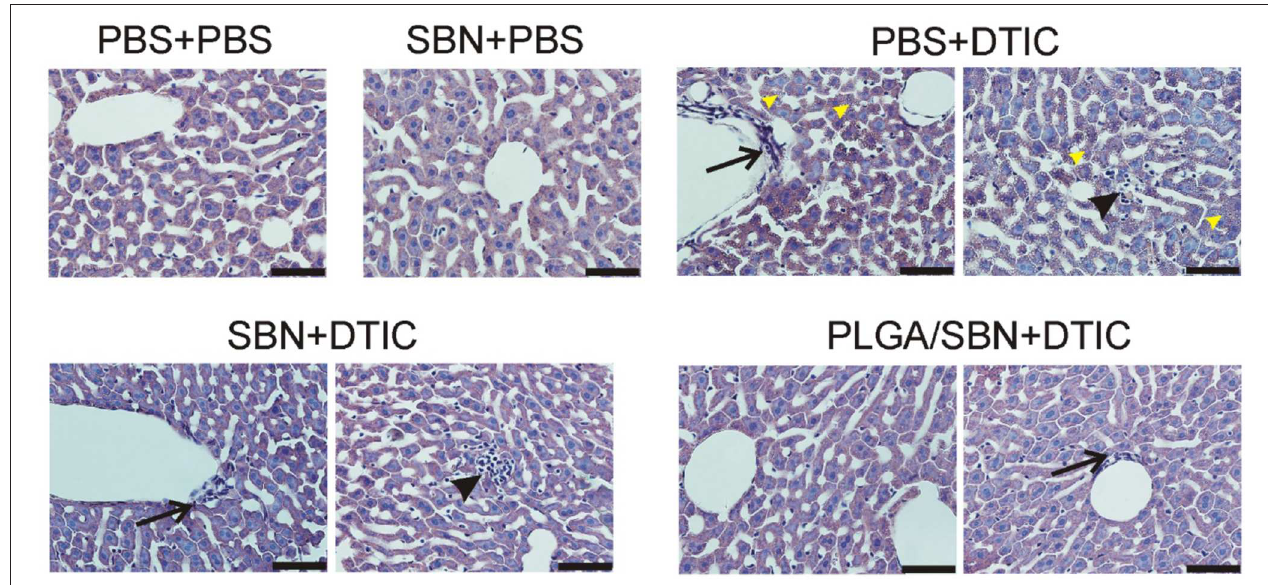
FIGURE 6 | Morphology of liver tissue after chemotherapy with DTIC. Tissue slices of 5 µ m thickness were stained with haematoxilyn-eosin. Black arrows denote mononuclear infiltration of sinusoids; black arrowheads denote necrotic foci; yellow arrowheads point to mild cholestasis. Scale bar is 50 µ m.